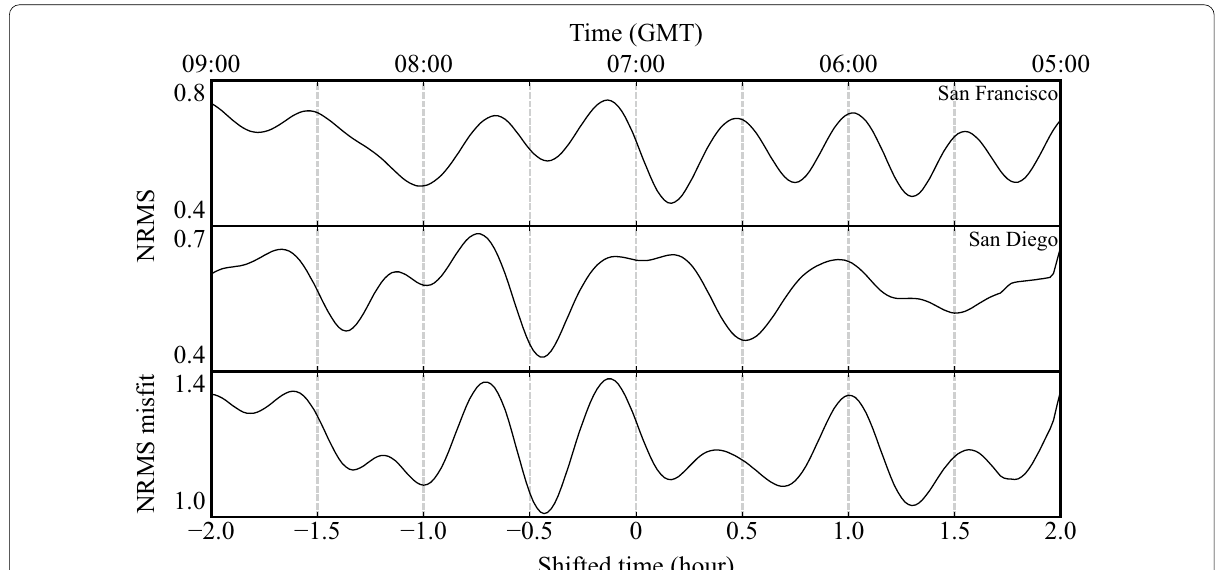
Fig. 6 Normalized root mean square (NRMS) and NRMS misfit between observed and simulated waveforms of the 1854 CE Ansei–Nankai tsunami at the San Francisco and San Diego tide gauge stations